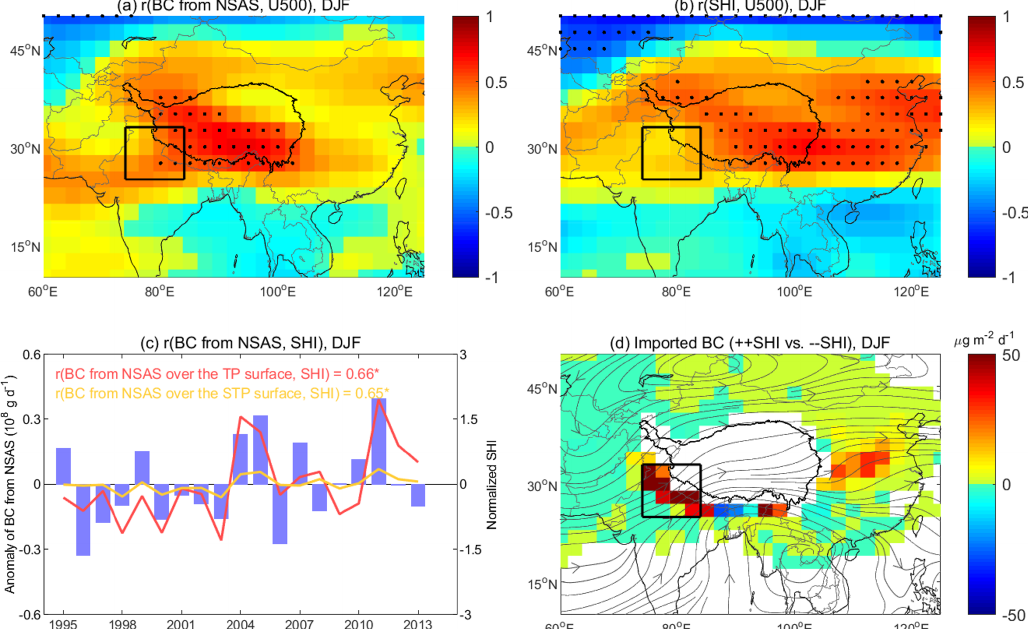
Figure 12. Connection between BC transport from South Asia to the TP surface and the Siberian High in winter. (a) Correlation coefficients ( r ) between zonal wind at 500hPa (U500) and imported BC from northern South Asia (NSAS) over the TP surface; (b) r between the SHI and U500; (c) inter-annual variations in the SHI and imported BC from NSAS to the surface of the TP and southern TP (STP); (d) differences in BC transport to the TP surface between the years with strong and weak Siberian High. Dots in (a) and (b) indicate that the r in the corresponding grid is statistically significant ( p < 0 . 05). An r with “*” in (c) indicates that the r is statistically significant ( p < 0.05). Streamlines in (d) are the differences between the years with strong and weak Siberian High at 500hPa. Boxed areas in (a) , (b) , and (d) indicate NSAS (see Fig. 4d). The dark black line in (a) , (b) , and (d) encloses the domain of the